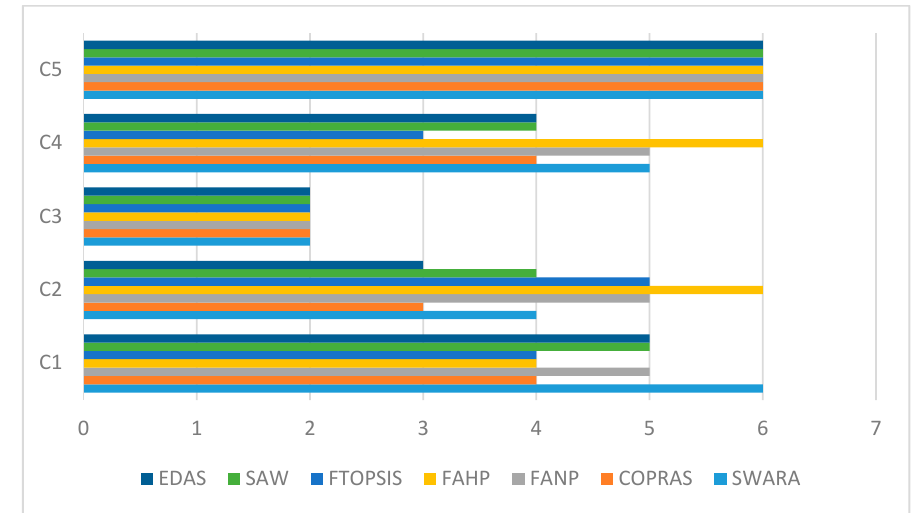
Figure 3. Specific value of the sensitivity analysis for each criterion.